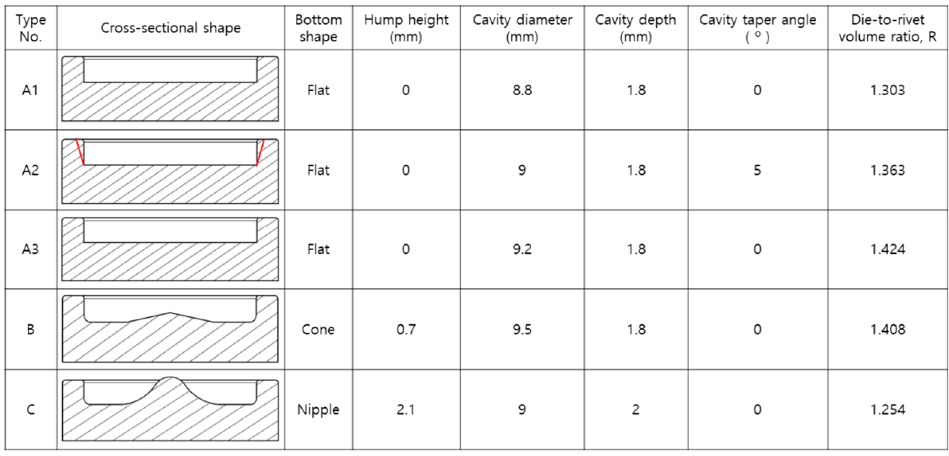
Figure 3. Die types used for SPR process in this study.